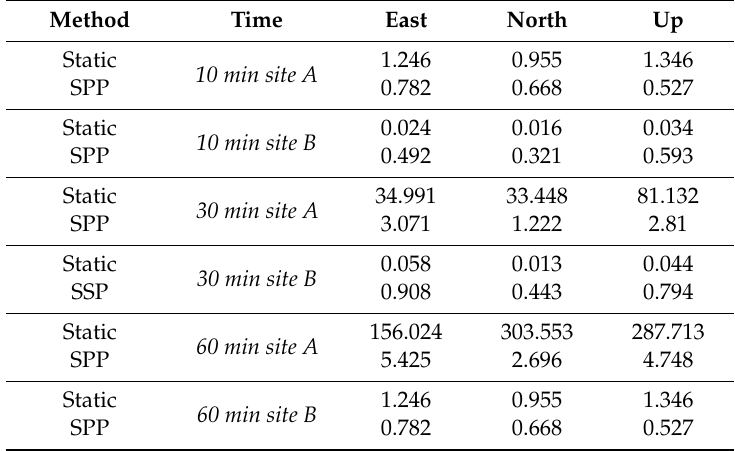
Table 5. Huawei P10 + . Results obtained with LGO software, considering di ff erent session lengths and locations. Values in